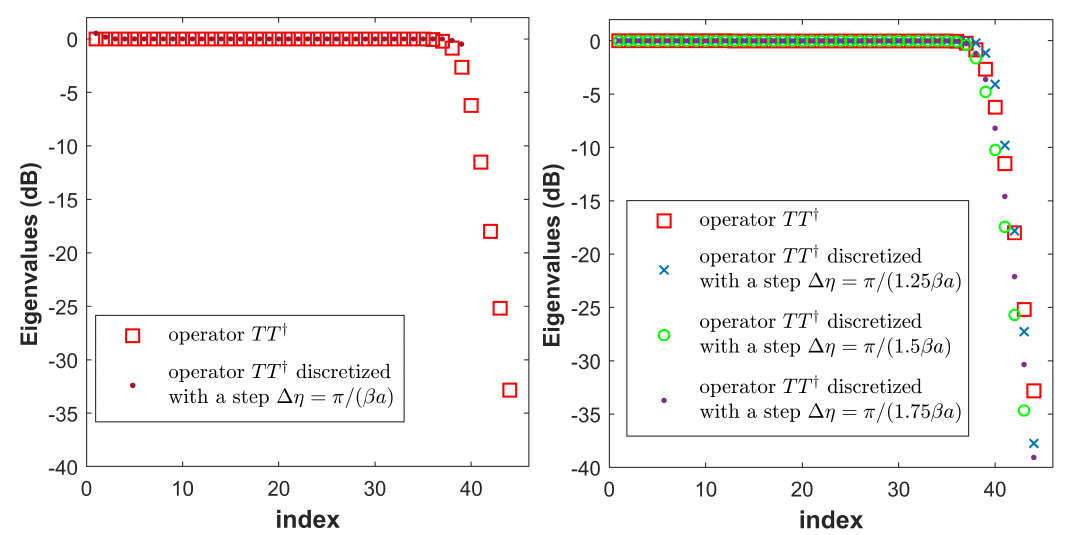
Figure 10. Eigenvalues of the operator T T † . The diagrams refer to the configuration a = 10 λ , z o = 5 λ , X o = 20 λ ( η ( X o ) =